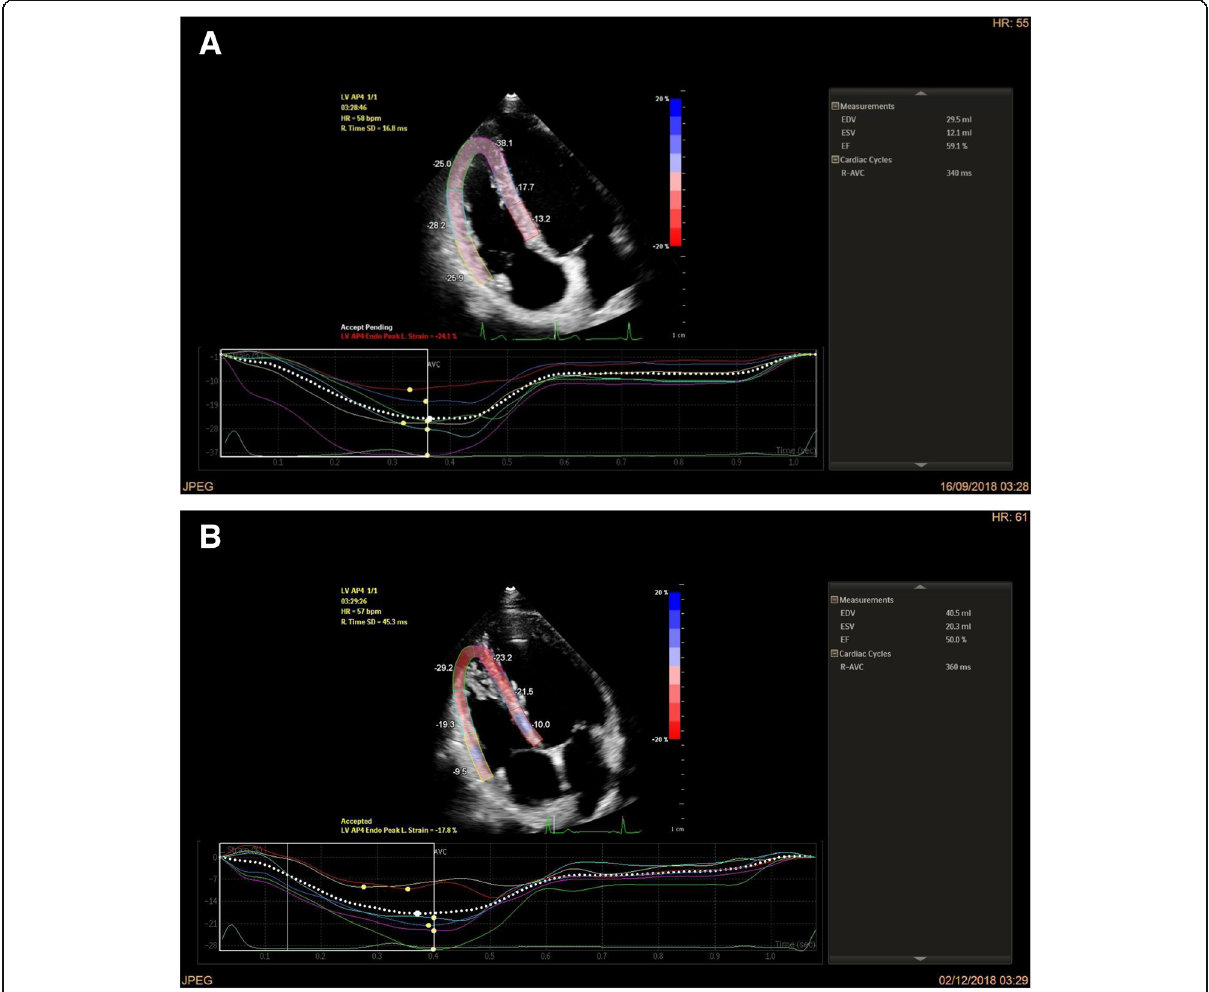
Fig. 1 Strain of the six segments of the right ventricle and GLS of the right ventricle of one of the non-smoking control subjects ( a ) and one of the chronic cigarette smokers ( b )